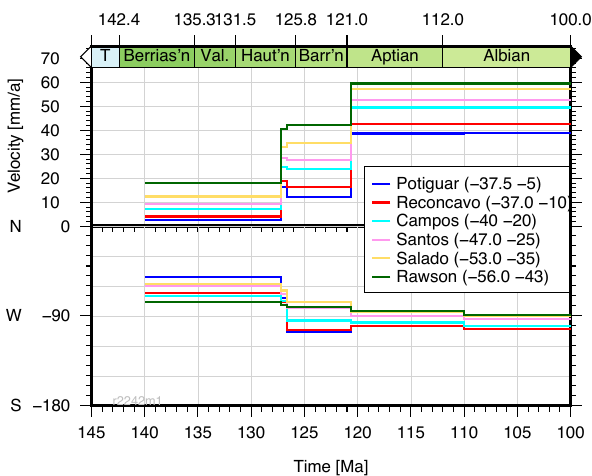
Fig. 15. Relative separation velocities and directions between 6 South American and Patagonian points relative to a fixed south- ern African plate using preferred plate kinematic model. Upper por- tion of figure shows extensional velocities over time, lower portion shows extension direction relative to a fixed southern African